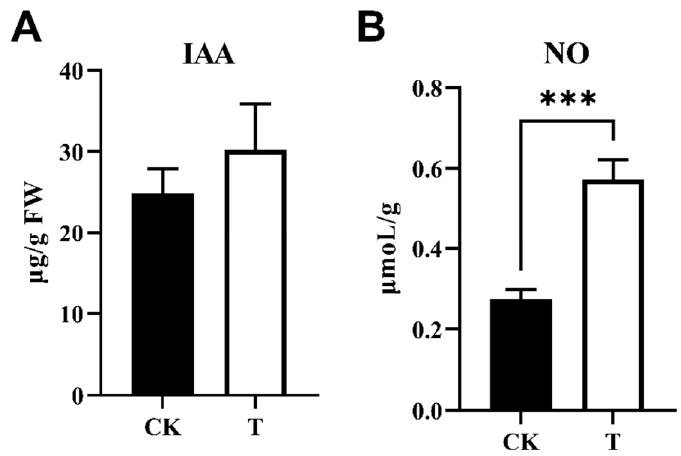
Figure 7. IAA (A) and NO (B) concentration in Cd-N shoots. (Values are mean with SD, IAA n = 5, NO n = 8, p value style is APA, ns: p > 0.05, ***: p < 0.001).